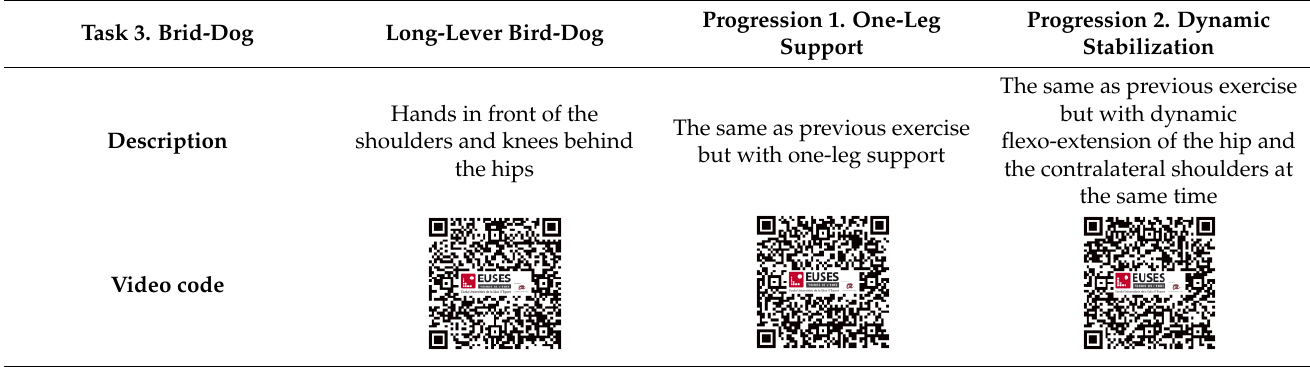
Table 8. Description and methodologic criteria of GCS group’s task 3 and its progressions. Task 3.